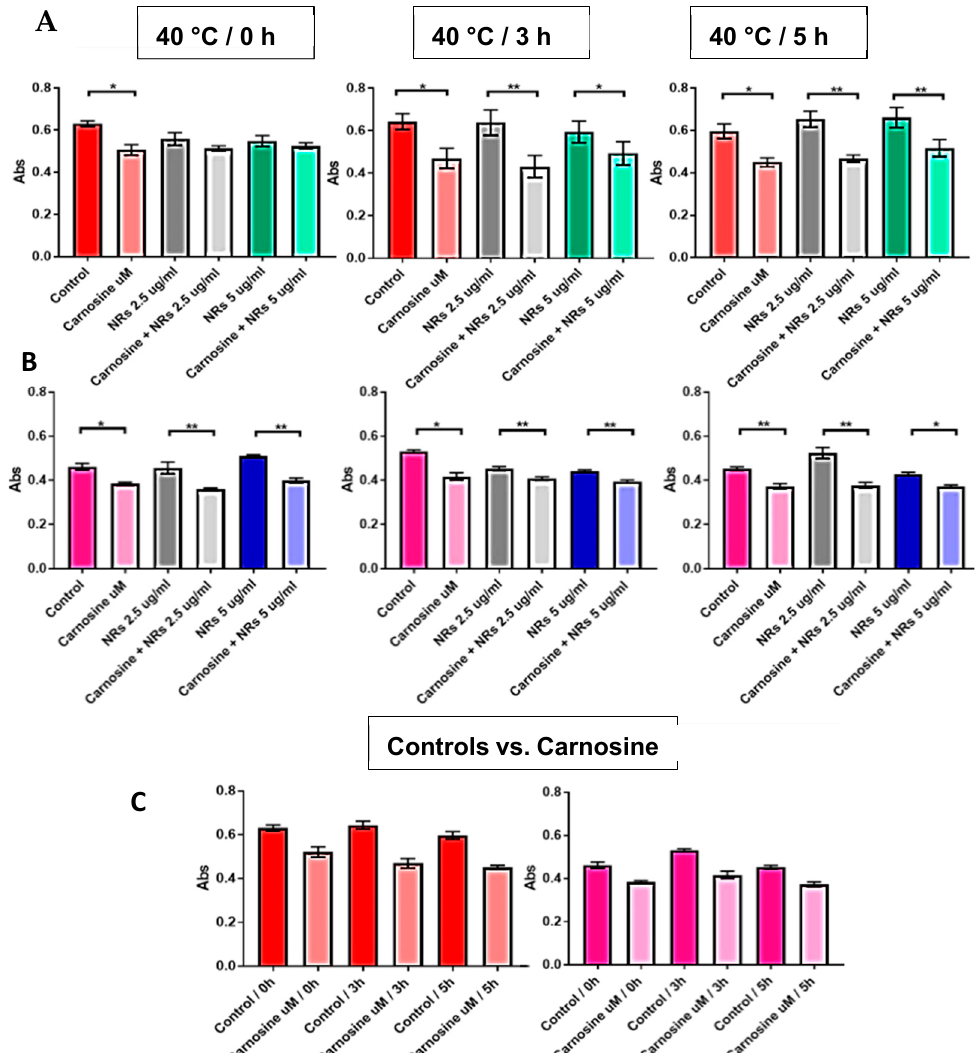
Figure 17. MTT assay on U87 cell line with same carnosine concentration 25 mM ( A ) carnosine loaded BPEI-coated IONRs and mixed for 5 min with the media ( B ) BPEI-coated IONRs added to the soluble carnosine in the media. In both cases, mild hyperthermia was applied. Comparing the controls shows the inefficiency of mild hyperthermia in killing cells because of the insignificant difference between the controls in all plates. The heat released the carnosine from the BPEI-coated IONRs after 3 to 5 h when it was bonded, while the effect was equal, without any significant difference, when the nano-rods existed in the same vicinity. Each treatment was repeated on 6 samples, then the T test was applied to address the significant changes. ( C ) Comparison of the repeatability of all controls from ( A , B ). (Abs = absorbance at 570 nm). The statistical significance level and indicated with (*) for p < 0.05, (**) for p < 0.01.